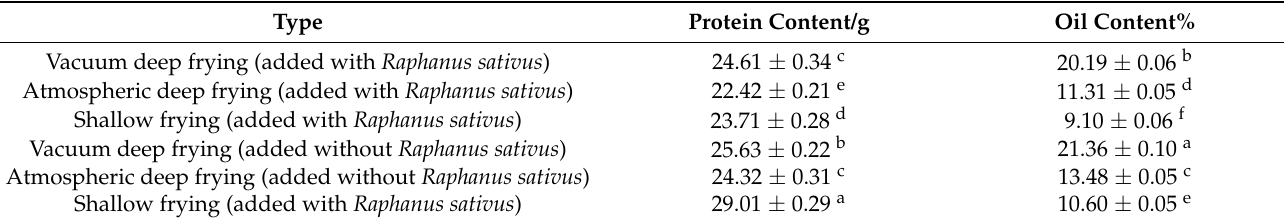
Table 5. Protein and fat contents of surimi